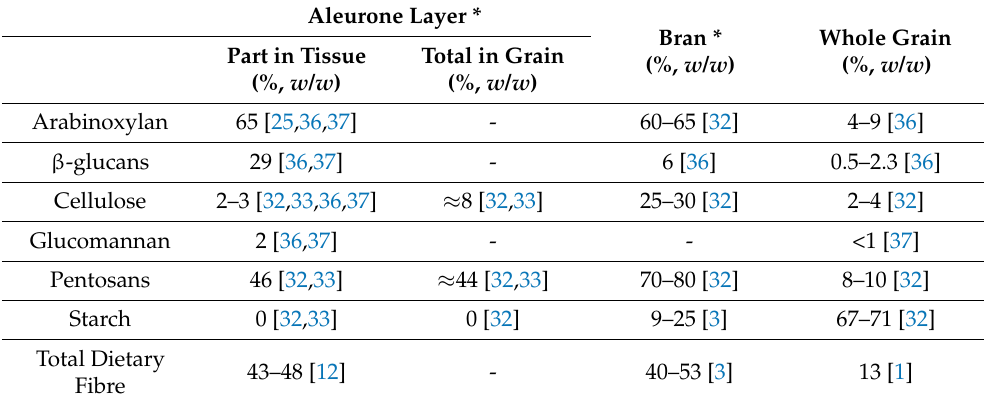
Table 1. Carbohydrates repartition in the wheat aleurone layer, bran and whole grain. Aleurone Layer